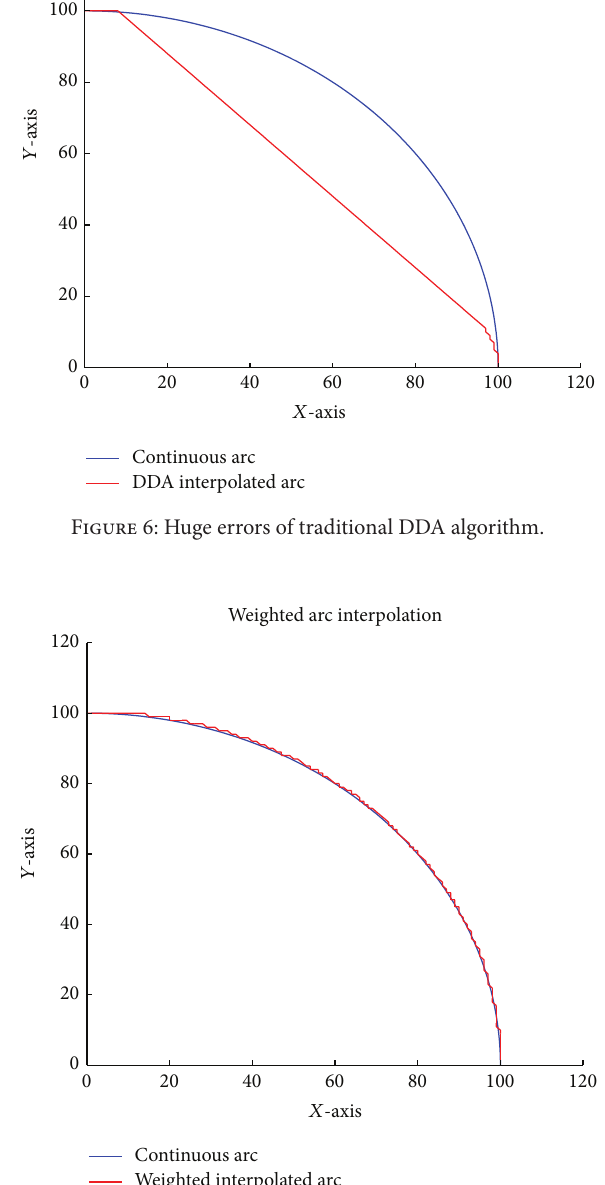
Figure 7: Better performance of weighted DDA